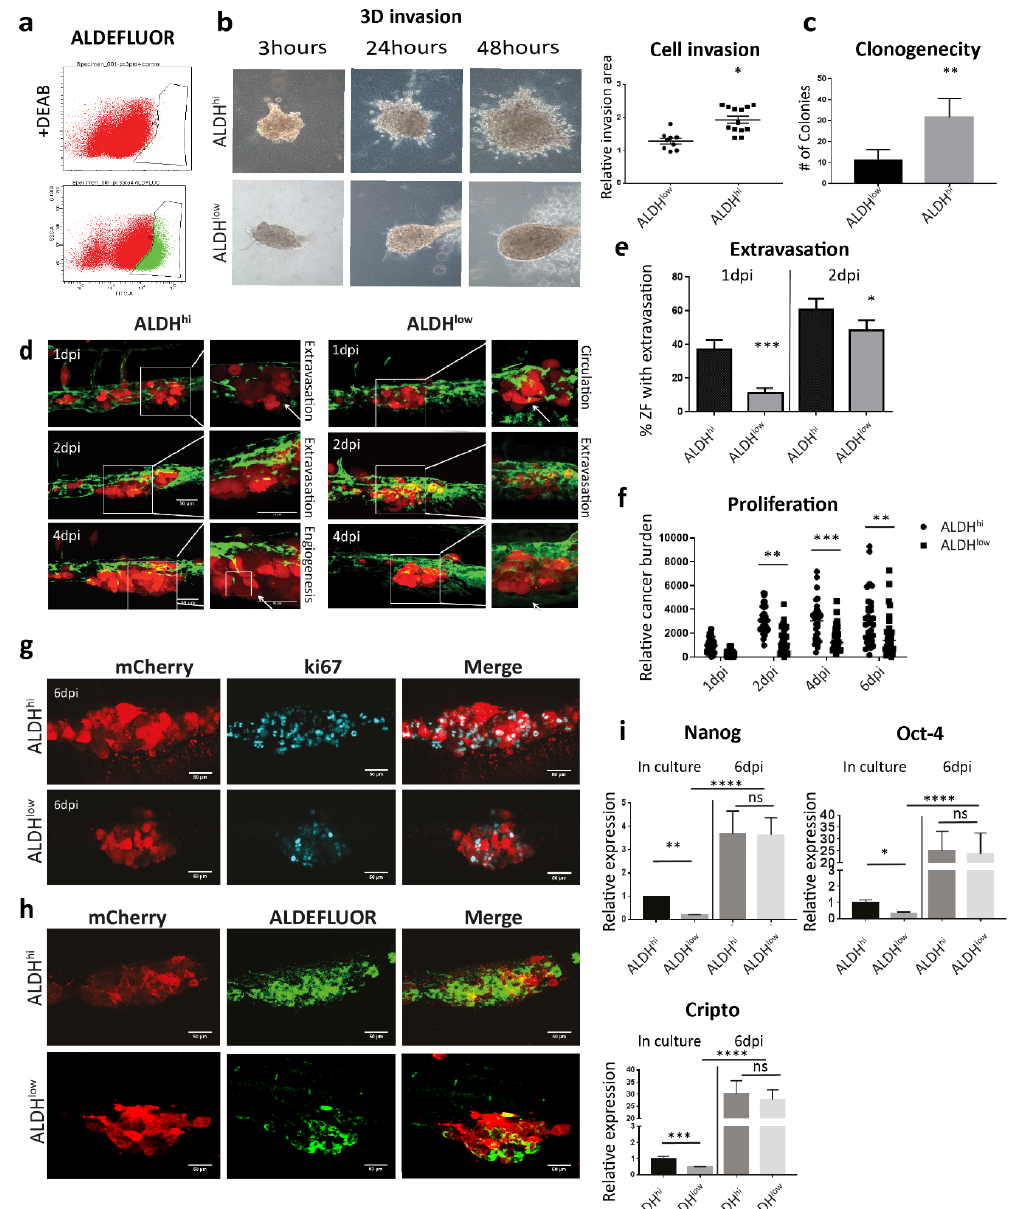
Figure 4. Both ALDH hi and ALDH low cell subpopulations obtain enhanced CSC traits after colonizing the ZF CHT area. ( a ) Gate setting for ALDH hi and ALDH low cell sorting. ( b ) After sorting, both ALDH hi and ALDH low subpopulations were respectively injected into type I collagen. Cell invasion was quantified by measuring the fold change of the invasive area after 48 h. Group size = 10. Data were presented as mean ± SD. ( c ) ALDH hi and ALDH low cells were seed for clonogenicity. Number of colonies formed by the cells was counted after 14 d of culture. Ten spheres were measured for each group. Data were presented as mean ± SD. ( d ) ALDH hi and ALDH low cells were injected into ZF after sorting. Confocal images were acquired at 1, 2, 4 and 6 dpi. Scale bar = 50um. Green, vessel. Red, cancer cells. Left, 20X magnification. Right, 63X magnification. ( e – f ) Extravasation and cancer cell burden at the metastatic site were analyzed. Group size = 30. Data were presented as mean ± SEM ( g – h ) Immunofluorescence against ki-67 and ALDEFLUOR staining were performed on engrafted ZF. Confocal images were acquired at the metastatic site. Scale bar = 50um. ( i ) Expression of stemness genes in ALDH hi and ALDH low was measured by qPCR in the cells after sorting and in the ZF metastases at 6 dpi. Experiments were independently repeated three times. Data were presented as mean ±